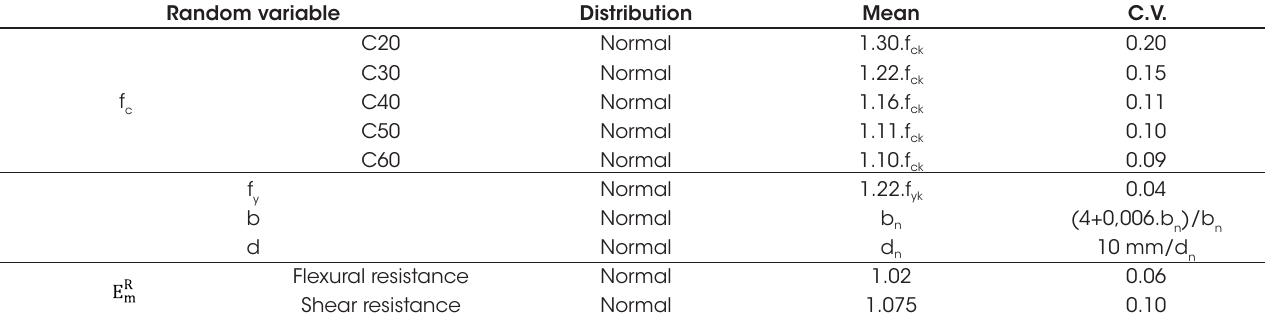
Resistance random variables Random variable